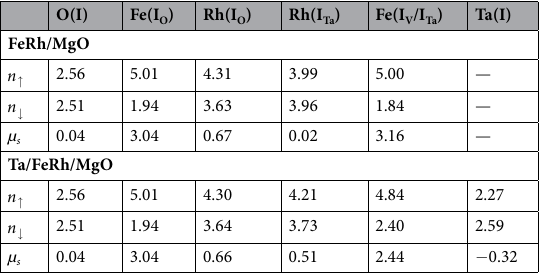
Table 2. The numbers of electrons in the majority-spin n ( ) ↑ and minority-spin ↓ n ( ) states and spin magnetic moments ( µ s ) of the interface (I) atoms for FeRh/MgO in the most stable AFM(I V )/FM(I O ) phase and Ta/FeRh/ MgO in the most stable FM(I Ta )/FM(I O ) phase. The letters I O and I Ta denote the interfaces next to the MgO and Ta layers, respectively. The letter I V denotes the interface of FeRh/MgO next to the vacuum level, where the local spin states and magnetic moments of the Fe(I V ) atom are